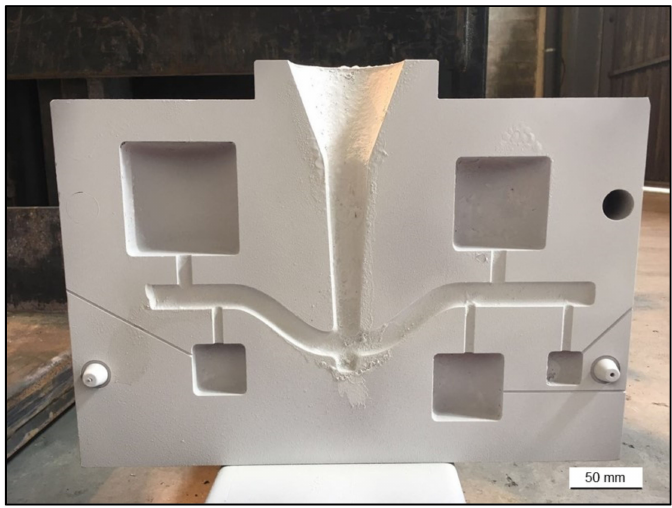
Figure 1. Lay out and the different cavities used to produce the cylindrical test castings using a die mold.